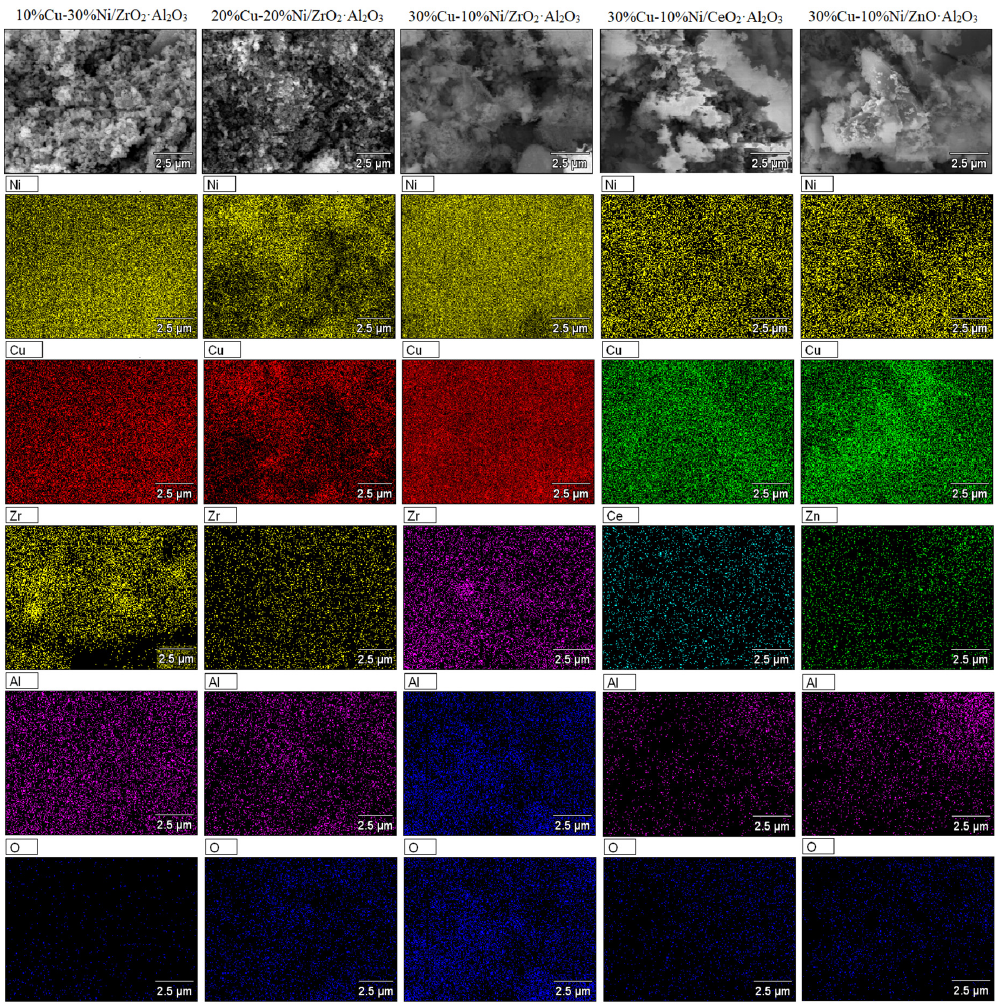
Figure 11. Scanning electron microscope images of all investigated calcined bimetallic systems.